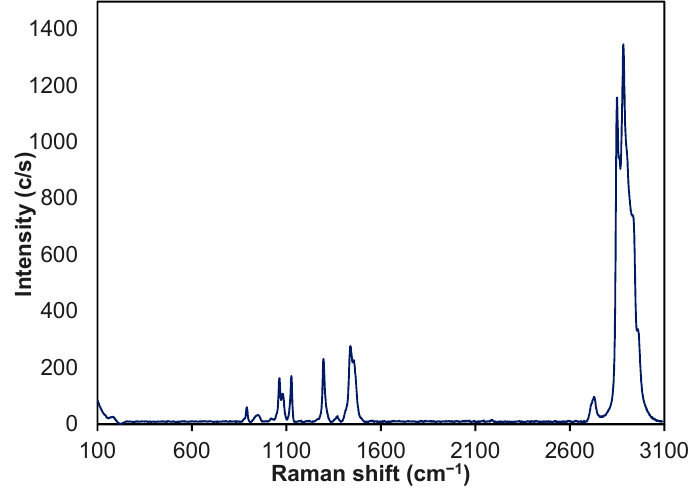
Figure 6. Raman spectrum of superhydrophobic coating assigned to laurate because of the fingerprint of alkyl chain.